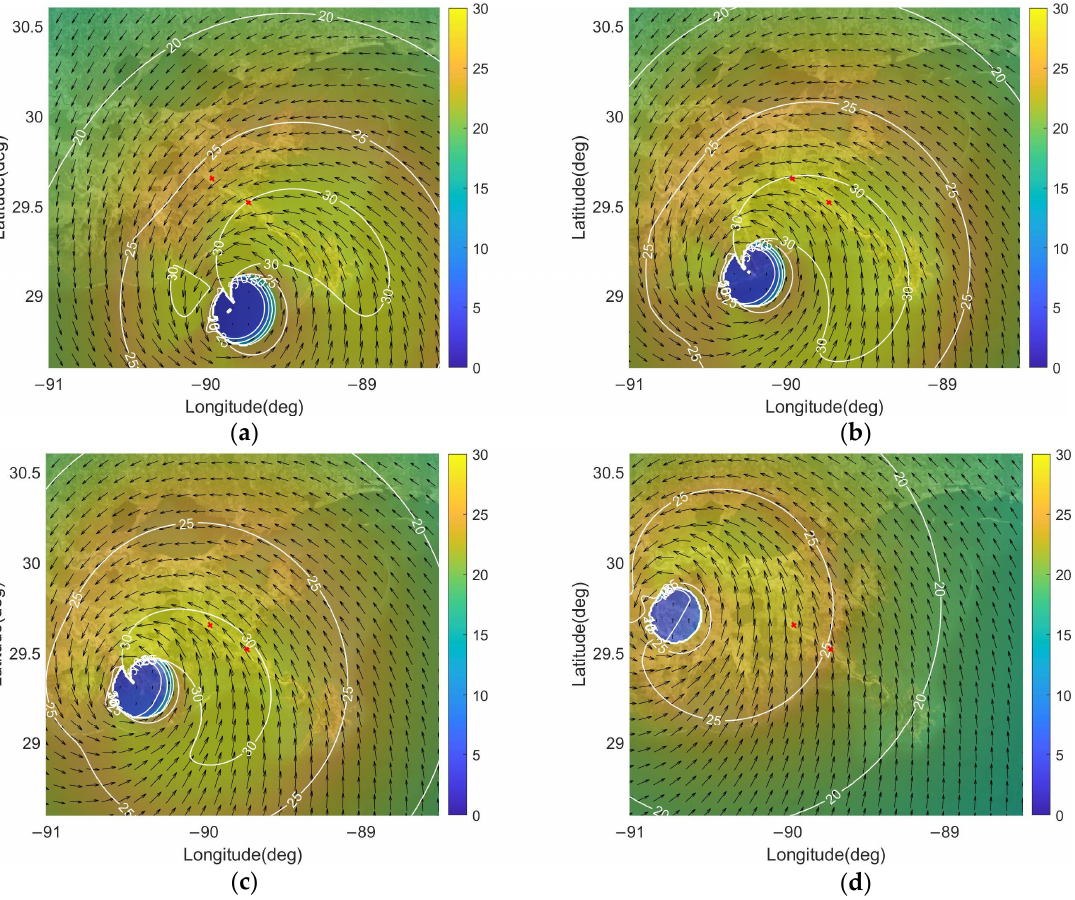
Figure 3. Distributions of hurricane winds (m/s) during Isaac (2012). White lines denote contour lines every 5 m/s. Black arrows denote wind direction. Two red symbols denote two levee-opening locations. ( a ) 03:00 UTC 29 August. ( b ) 08:00 UTC 29 August. ( c ) 11:00 UTC 29 August. ( d ) 17:00 UTC 29 August.